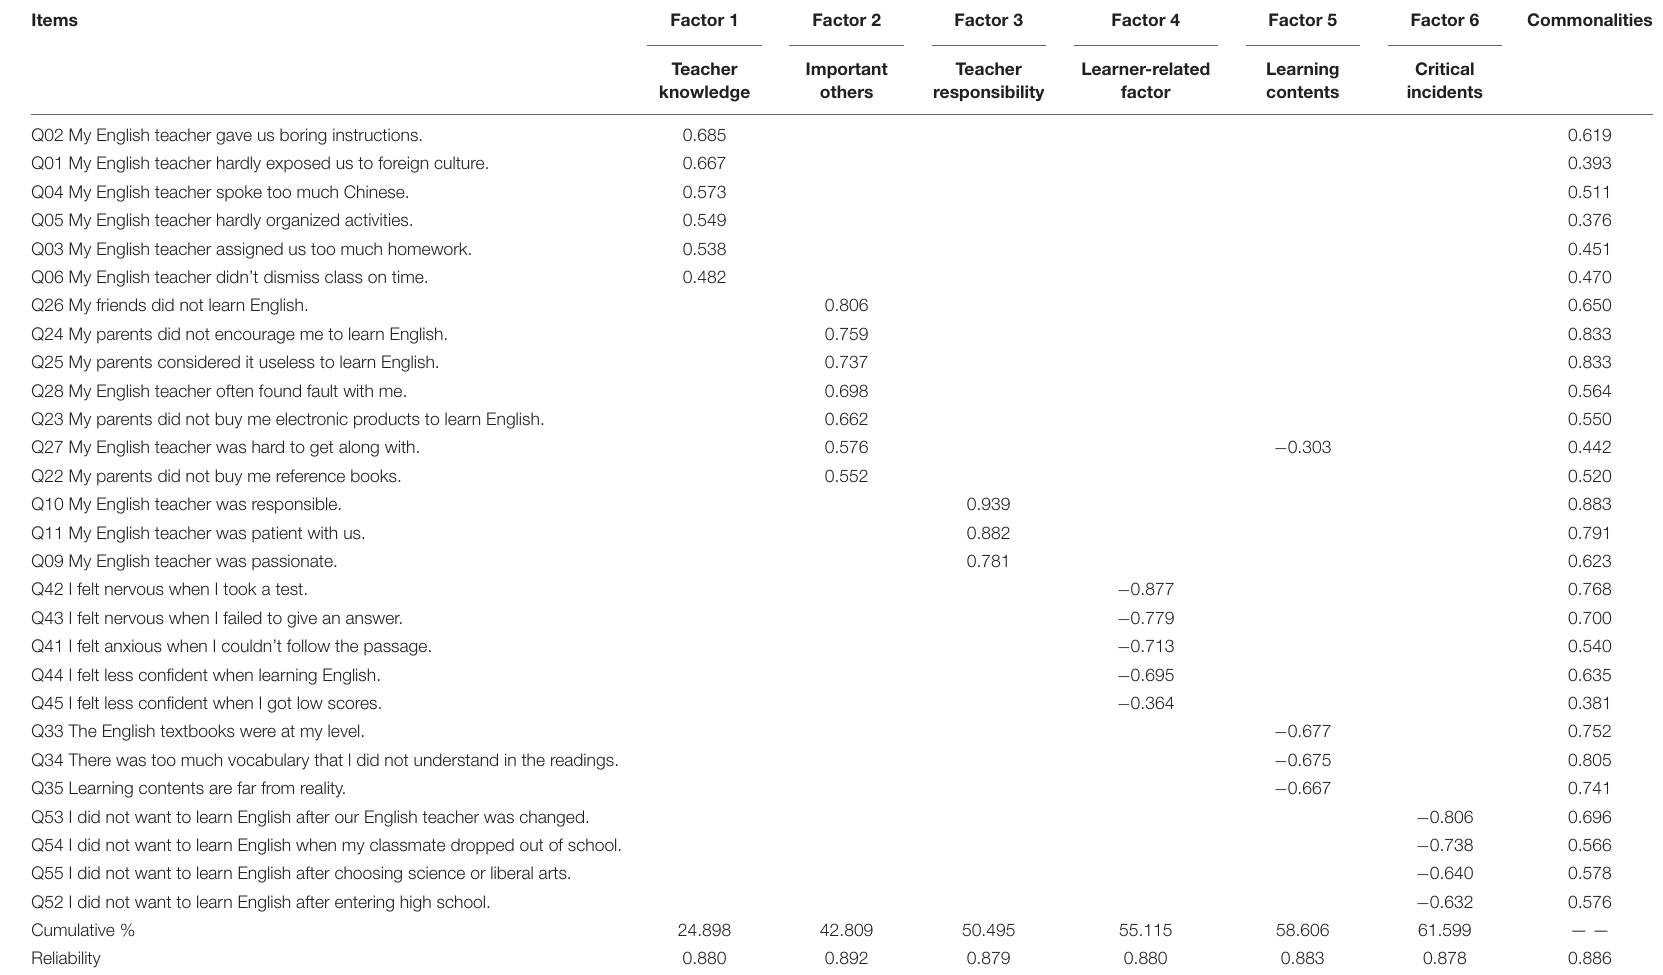
TABLE 3 | Exploratory Factor Analysis (EFA) results of the 28-item scale (Pattern Matrix).